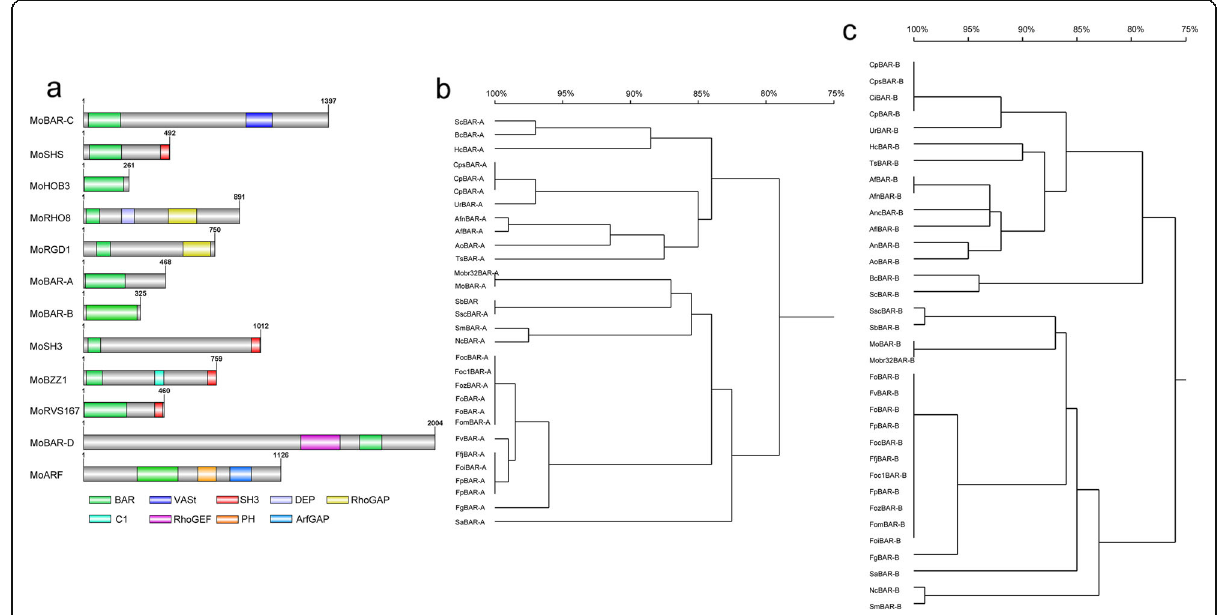
Fig. 1 Domain composition and homology of BAR containing-proteins in Magnaporthe oryzae . a Schematic presentation of M. oryzae proteins containing BAR domain as a unitary domain or in combination with other functional domains. b Domain homology tree constructed exclusively